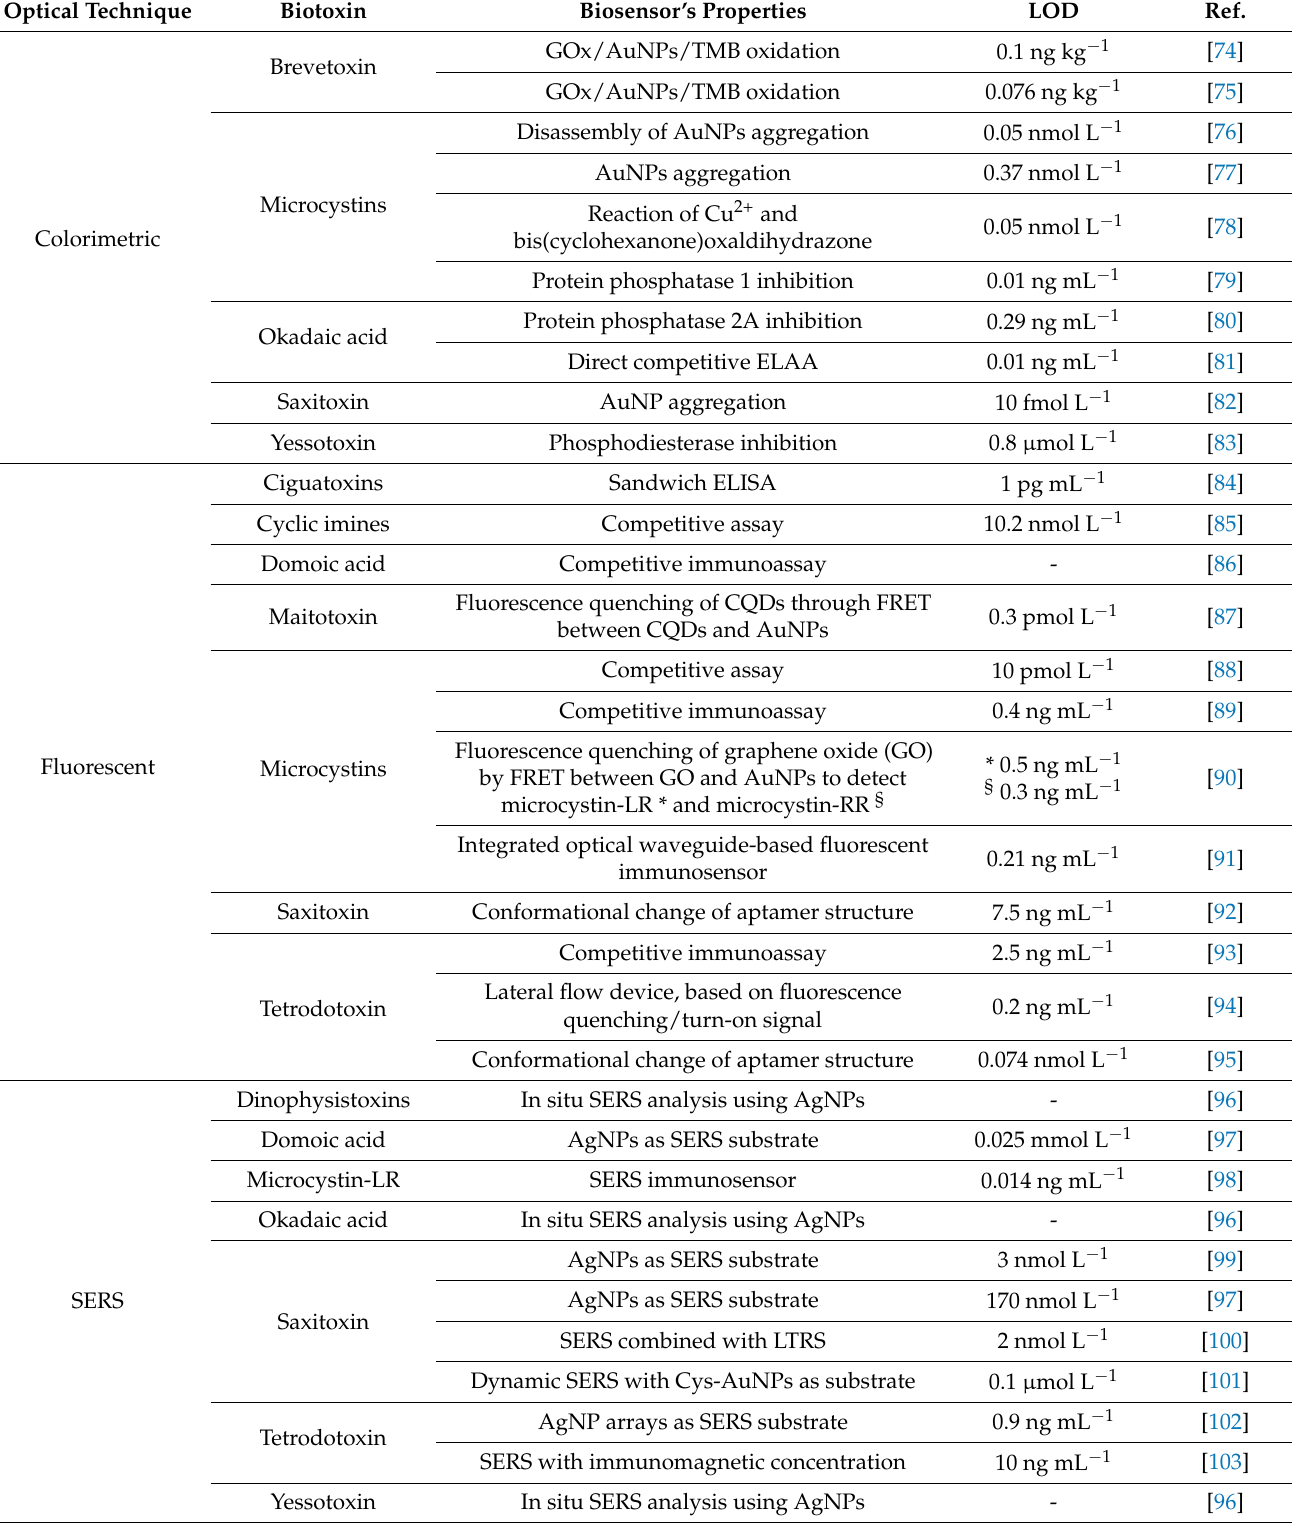
Table 2. Summary of common optical biosensors applied to detect biotoxins. In cases where more than one biotoxin was studied in the cited article, LOD is linked by symbols to the respective